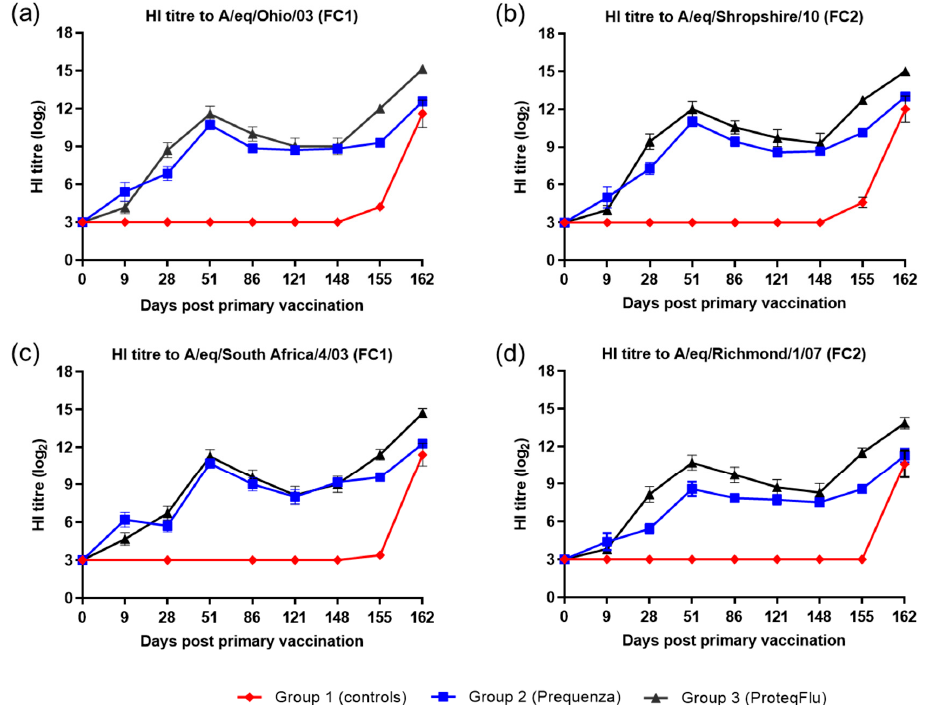
Figure 2. Mean haemagglutination inhibition (HI) antibody titre response in group 1–3 against H3N8 EIV ( a ) A / equine / Ohio / 03 (FC1), ( b ) A / equine / Shropshire / 10 (FC2), ( c ) A / equine / South Africa / 4 / 03 (FC1) and ( d ) A / equine / Richmond / 1 / 07 (FC2). Day 0, V1; Day 28, V2; Day 148, challenge. Red diamond = group 1, unvaccinated control group; blue square = group 2, Equilis Prequenza-vaccinated group; black triangle = group 3, ProteqFlu-vaccinated group. Error bars represent SEM. A titre of <4 was converted to 3 for graphical presentation.